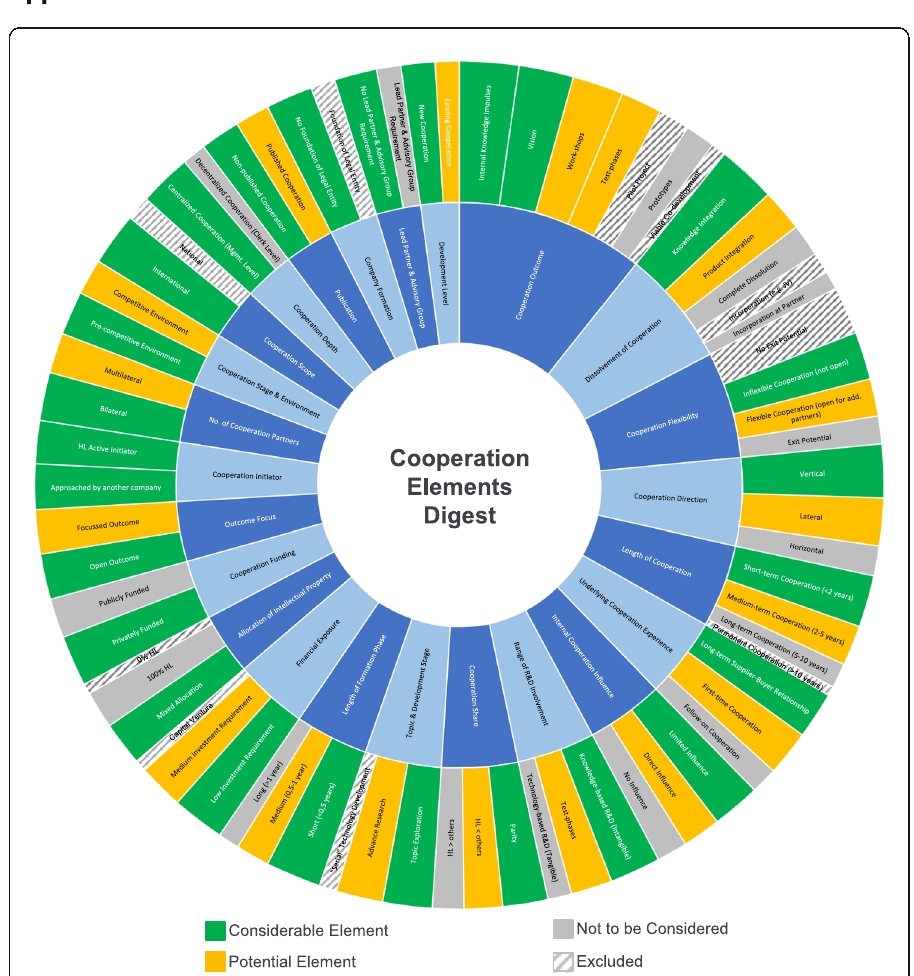
Fig. 8 R&D Cooperation Process. Source: Own